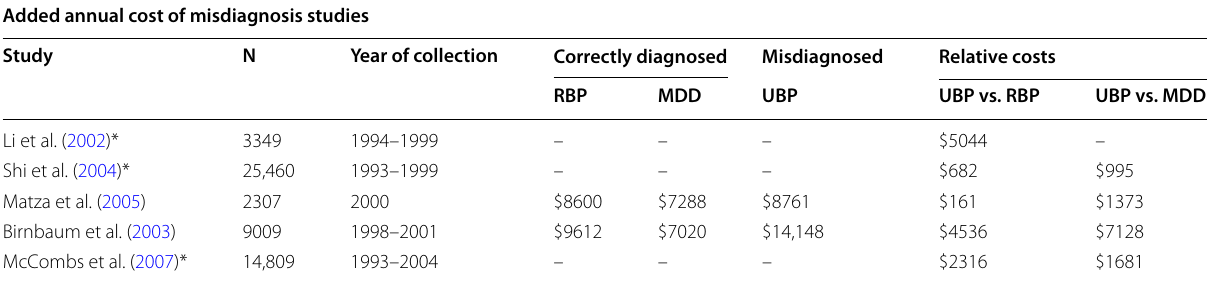
Relative costs show the difference in costs between correctly diagnosed patients and UBP. Reported costs reflect values as published in the respective studies and have not been adjusted for inflation. N: Sample size; BD: Bipolar disorder; MDD: Major depressive disorder; RBP: Recognised bipolar disorder patients;